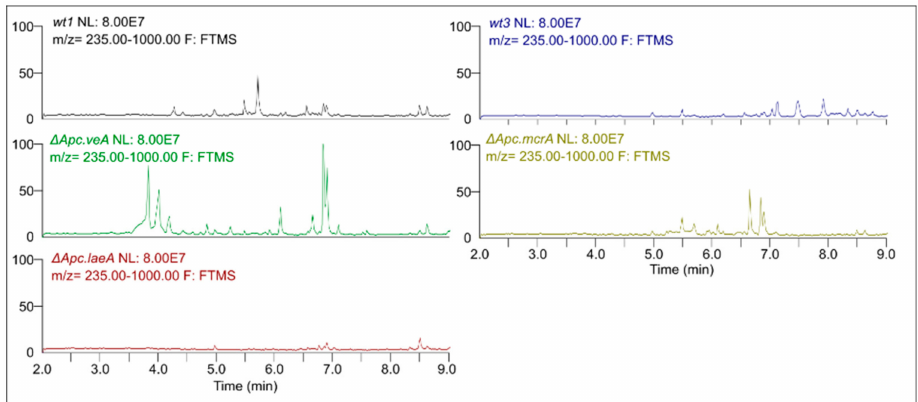
Figure 1. Representative UPLC-HRMS chromatograms obtained for extracts from wt1, (cid:52) Apc.laeA , (cid:52) Apc.veA , wt3, and (cid:52) Apc.mcrA strains of A. pachycristatus NRRL 11440 grown in SMY medium.